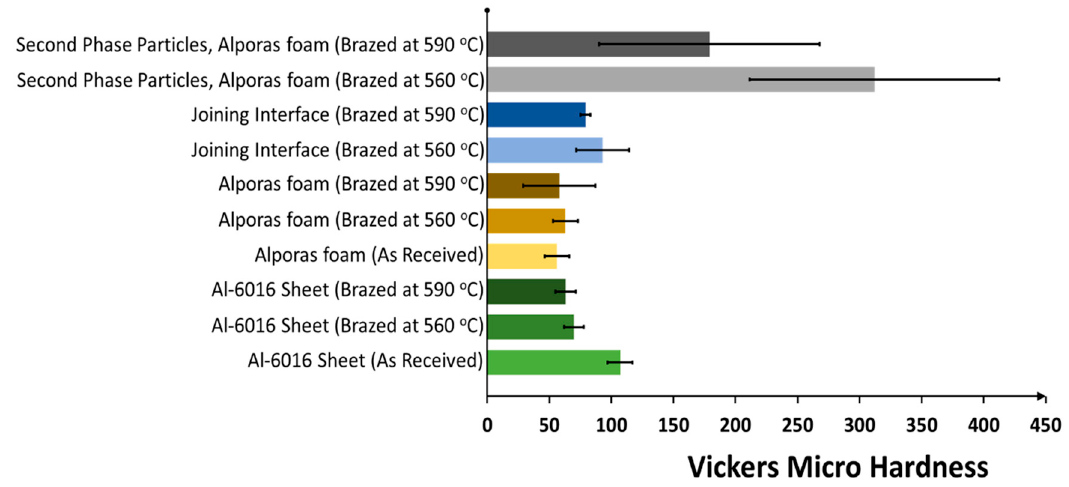
Figure 7. SEM and back-scattered images of Al-alloy foam/Al-Mg-Si-Ti/Al-alloy sheet interface. ( a ) Micrograph in secondary electron mode. ( b ) Micrograph in backscattered electron mode. Arrows indicate spot EDS analysis.